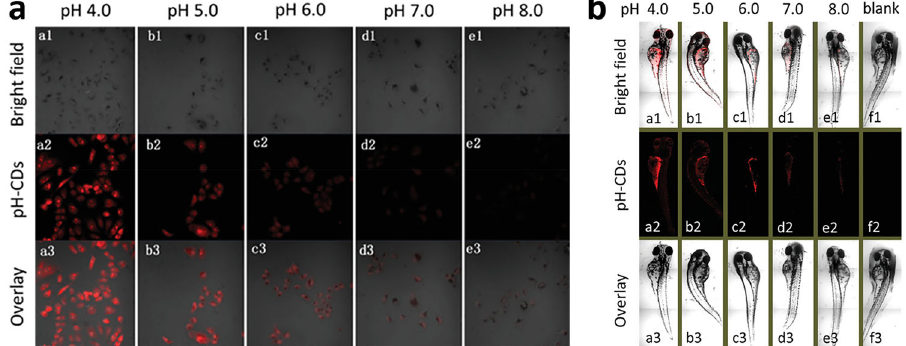
Fig. 4 In vitro and in vivo pH sensing using RTCDs. Two-photon fl uorescence images of a MCF-7 cells and b zebra fi sh incubated with RTCDs (pH-CDs) at different pH values ( λ ex = 690 nm, λ em = 620 – 660 nm). (Fig. 4a, b adapted with permission from ref. 42 , Copyright 2019 Wiley).